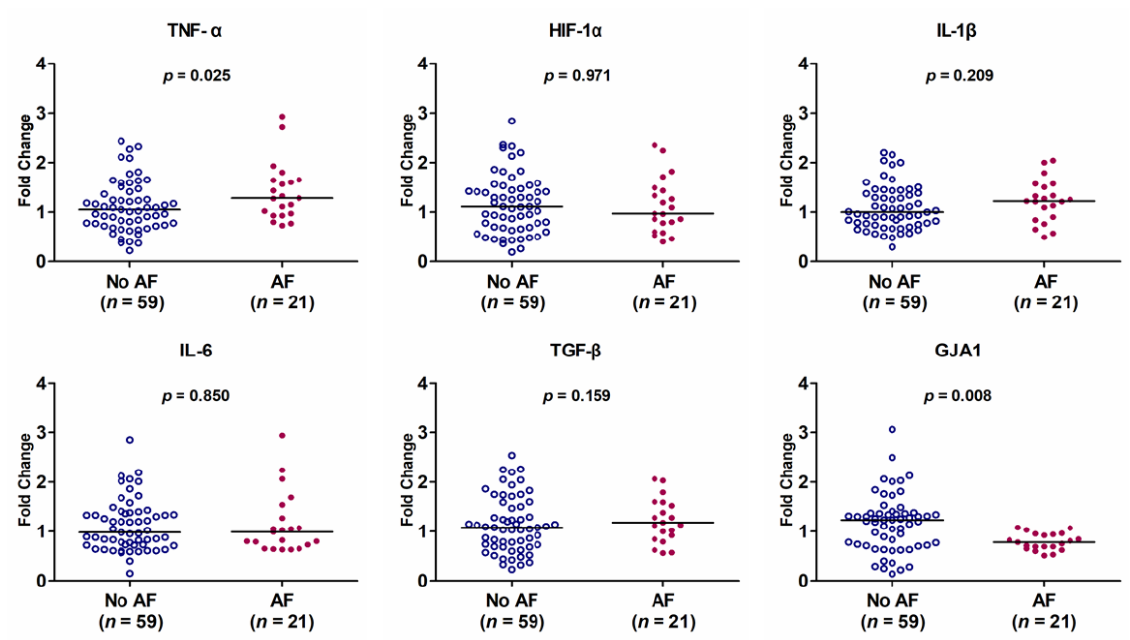
Figure 2. mRNA-level expressions in HL-1 cells incubated with exosomes from obstructive sleep apnea syndrome patients with and without atrial fibrillation (AF). The y -axis represents the fold change of the gene expression level in patients with AF compared to patients without AF. The p -value analyzed by Mann–Whitney U test indicates statistical significance as evaluated between patients with AF ( n = 21) and those without AF ( n = 59) using ∆ Ct values.